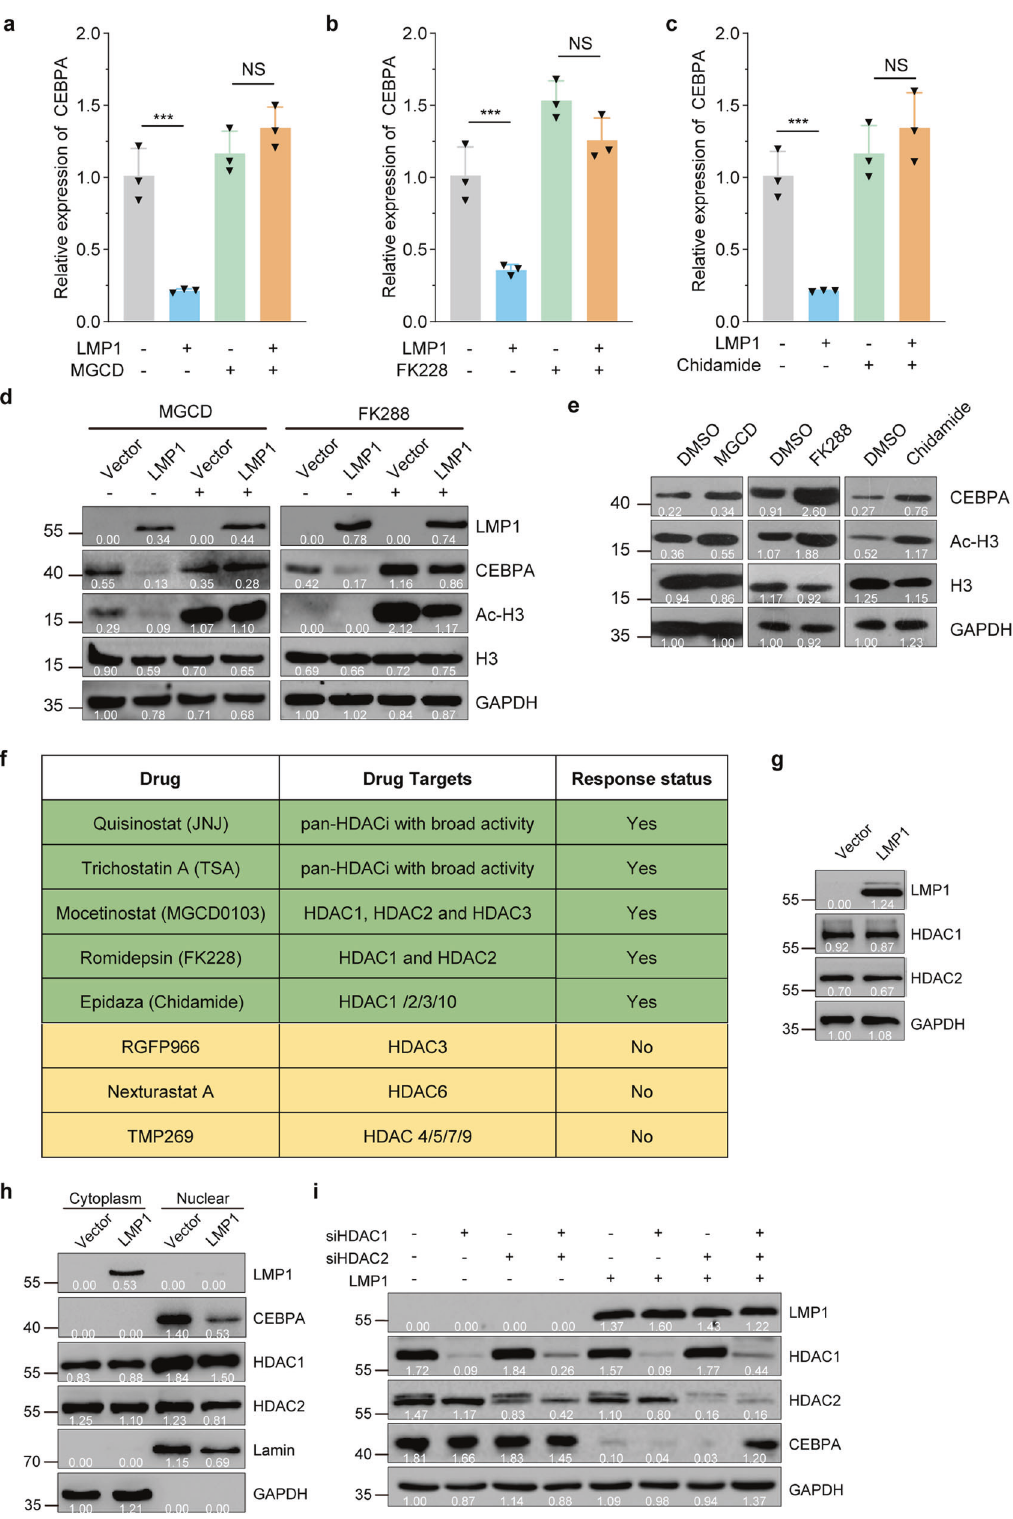
mice and expression of LMP1 was induced by Dox administration. Then the mice were divided into two groups, which were treated with either FK228 or vehicles (Fig. 8f). Treatment with FK228 was performed when tumors were clearly detectable, and thereafter, tumor volume was measured every 2 days until some